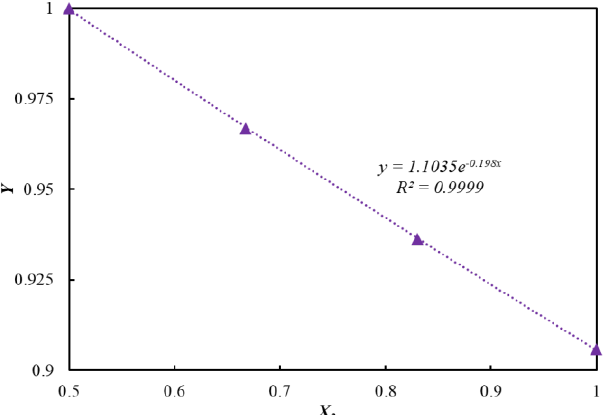
Figure 11. The influence of downhole perforation e ff ective volume on perforation peak pressure.